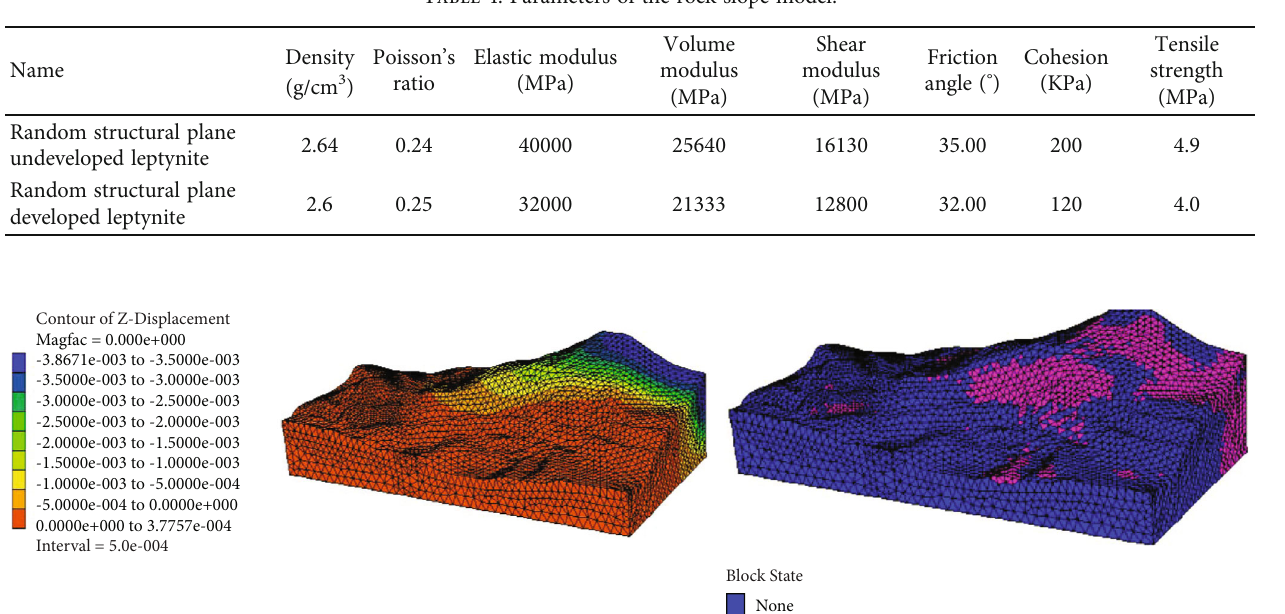
Table 4: Parameters of the rock slope model.